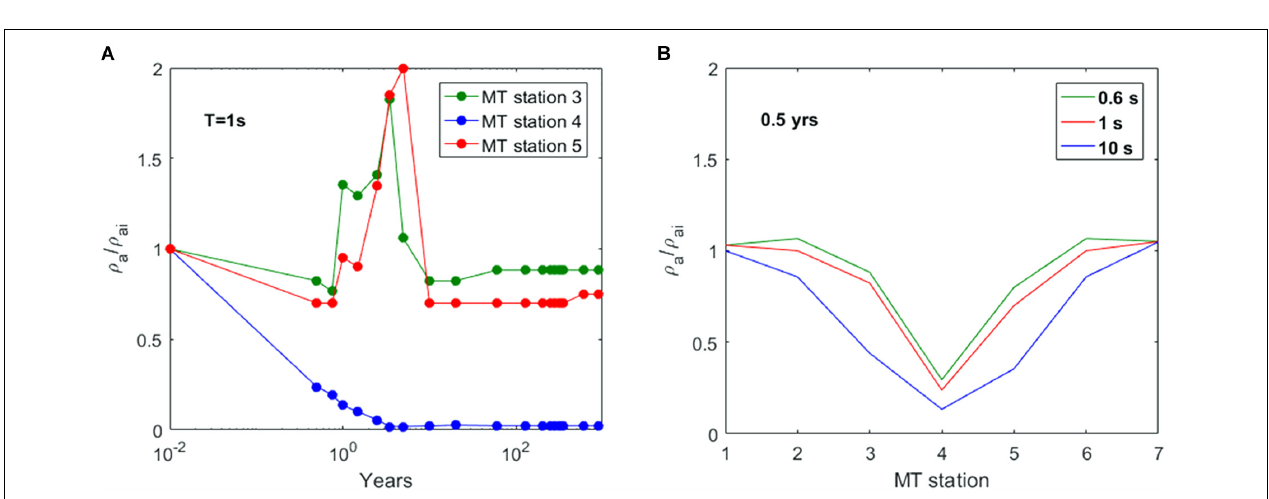
FIGURE 10 | Time evolution of the gas saturation distribution related to Scenario II in the vertical section along the red line shown in Figure 3 . The first panel of the sequence shows the initial gas saturation distribution. The green triangles 1–7 indicate the MT stations.